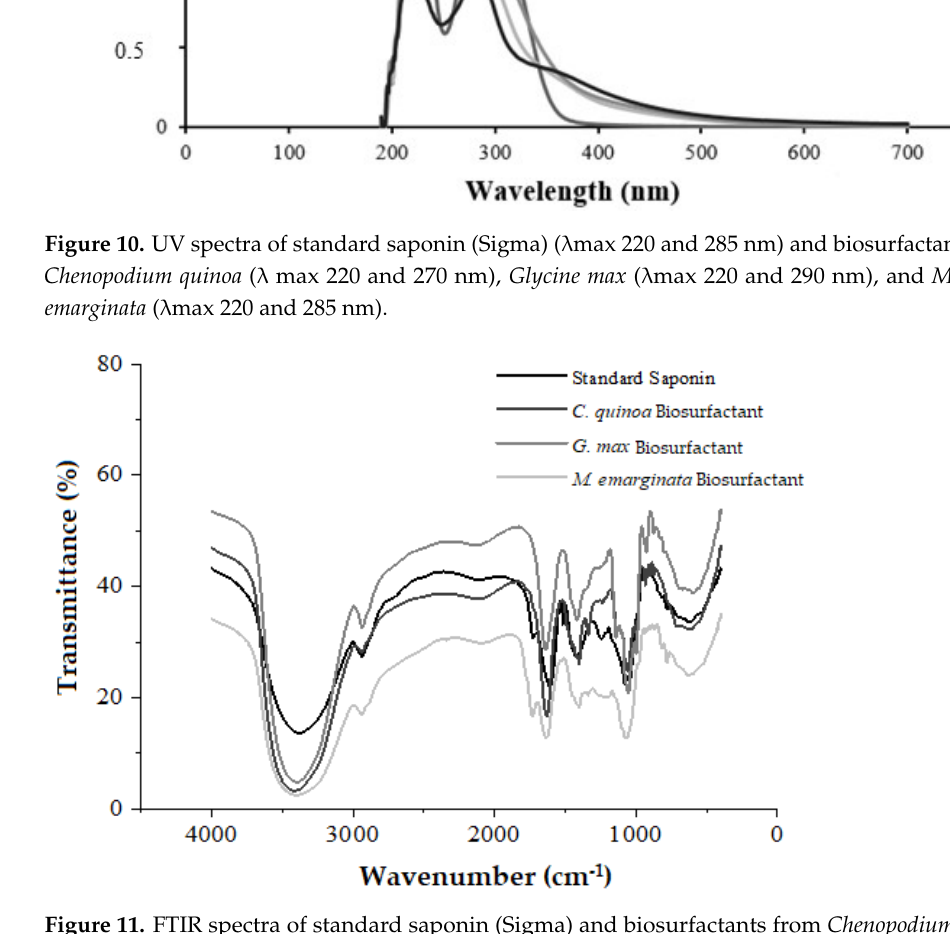
Figure 10. UV spectra of standard saponin (Sigma) ( λ max 220 and 285 nm) and biosurfactants from Chenopodium quinoa ( λ max 220 and 270 nm), Glycine max ( λ max 220 and 290 nm), and Malpighia